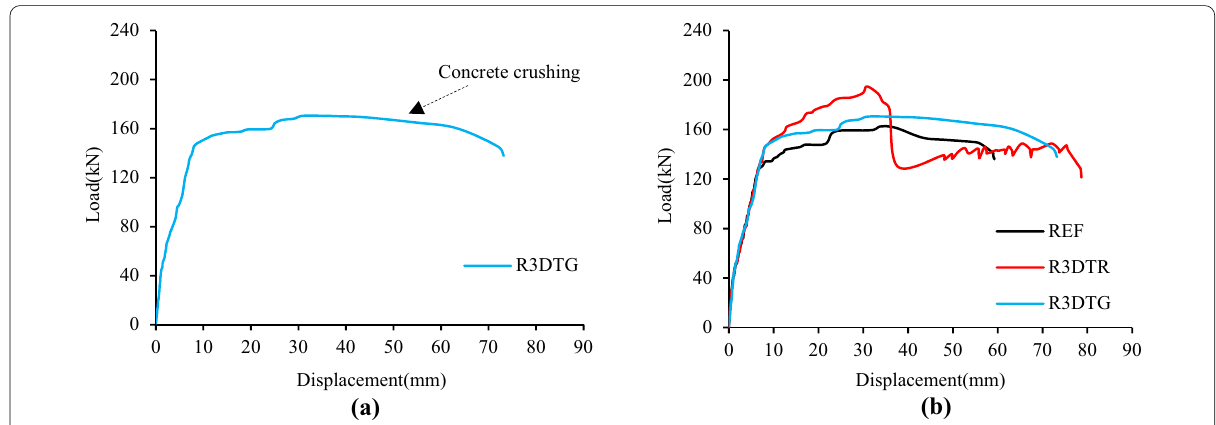
Fig. 15 Load–displacement curves of tested beams: a R3DTG specimen, and b REF, R3DTR and R3DTG specimens.